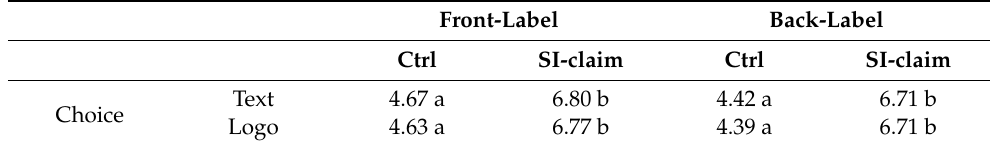
Table 5. Sustainability perception of the SI-labeled wines depending on label and consumer choice. The sustainability scale went from one-not sustainable at all, to nine-very sustainable. SI-sustainable irrigation